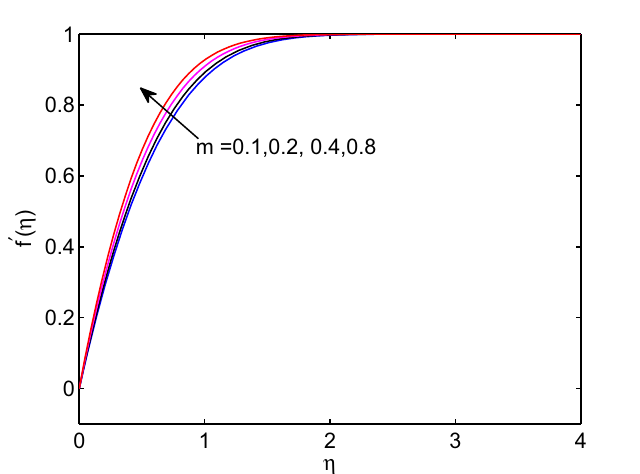
Figure 15. Permeability effects on volumetric concentration profiles.